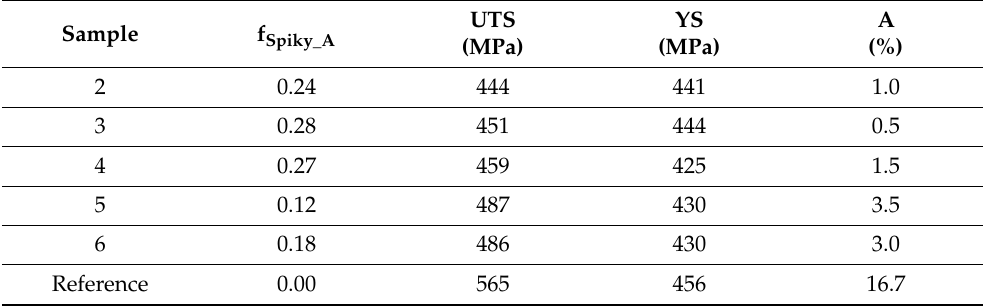
Table 4. Effect of different spiky graphite contents on tensile properties of a high silicon ductile iron alloy [56].